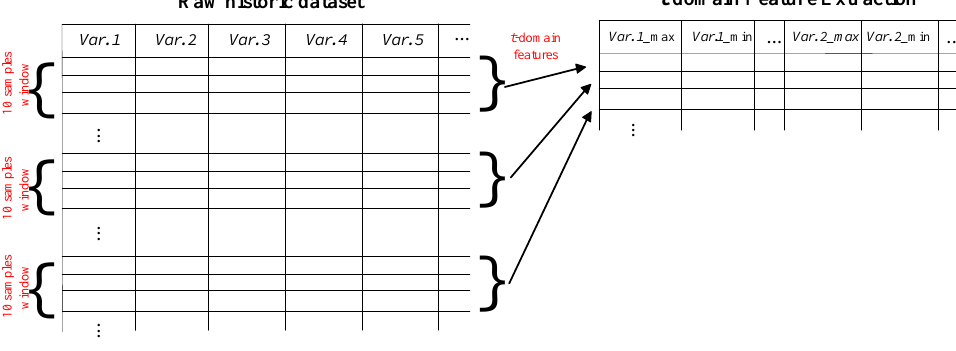
Figure 13. Schematic of the time-domain feature extraction